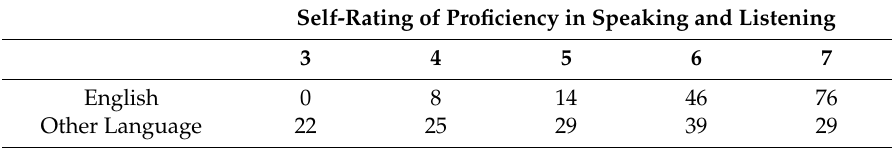
Table 1. Frequency distributions for English and “other” language proficiencies.